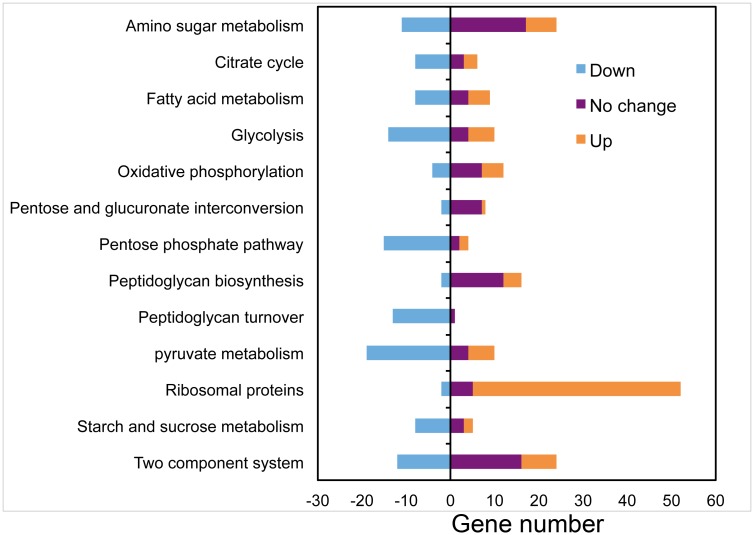
Pathway analysis plot.Number of up- and down-regulated genes in A. actinomycetemcomitans IDH781 strain. In this comparison, up-regulated genes in the the mutant strain EA1002 deficient in PGA synthesis are shown in light blue. Data are grouped according to the major role categories. Positive and negative numbers correspond to the up- and down-regulated genes, respectively. Statistical values for the various pathways are provided in S2 and S3 Tables.